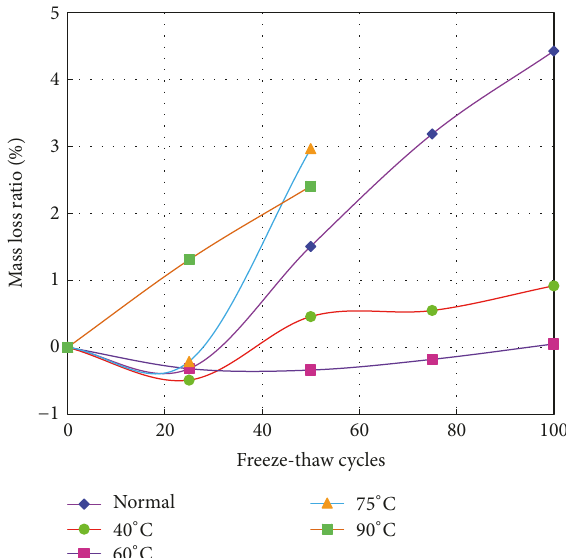
Figure 9: Relationship between the number of freeze-thaw cycles and the mass loss ratios under different